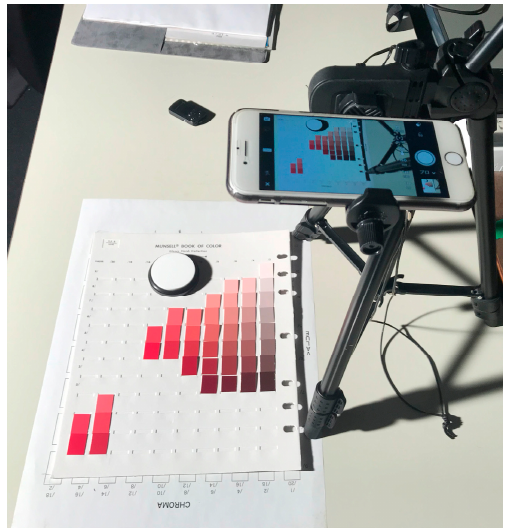
Figure 8. Setup for color sample imaging by a mobile phone camera.